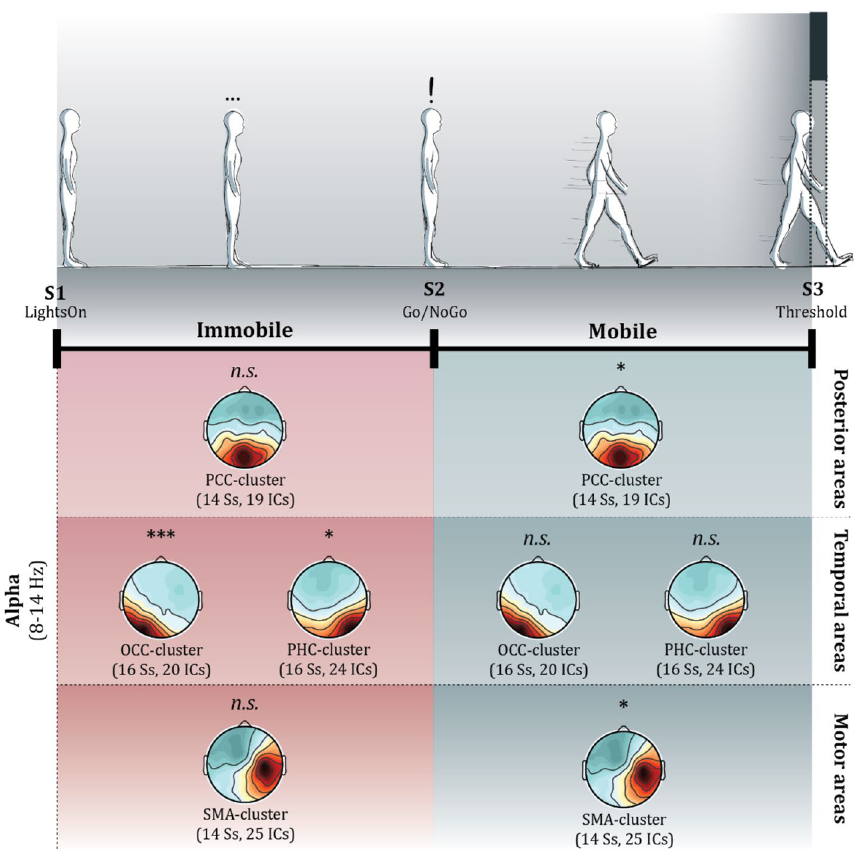
Figure 5. The top panel illustrates the state of the participants while the dense black line represents the timeline. The panel beneath displays the average scalp maps where the asterisk represents the respective ANOVA results (see Results section). The panels are divided by their area to provide an overview of the observed